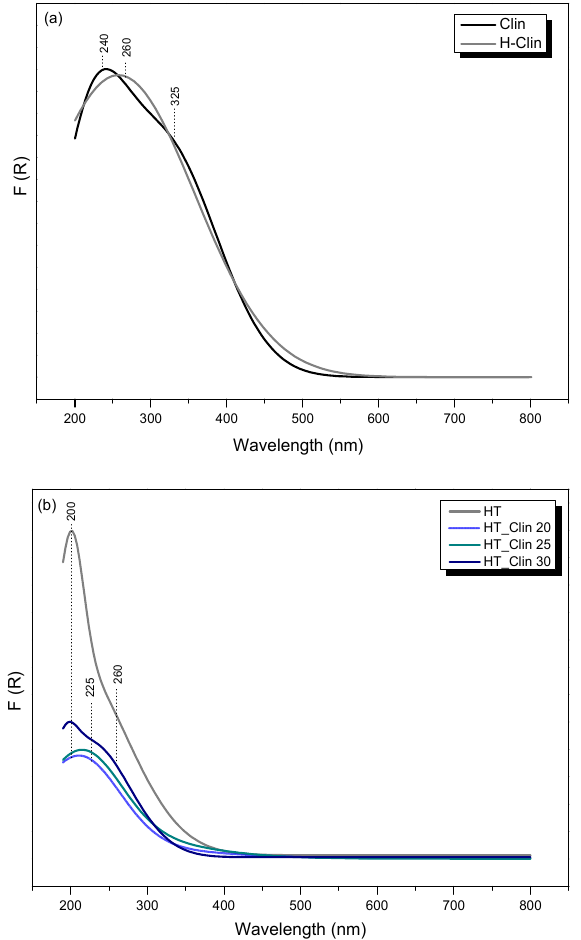
Figure 9. UV-Vis-DRS spectra recorded for ( a ) raw and protonated clinoptilolite and ( b ) non-supported and clinoptilolite-supported hydrotalcite.